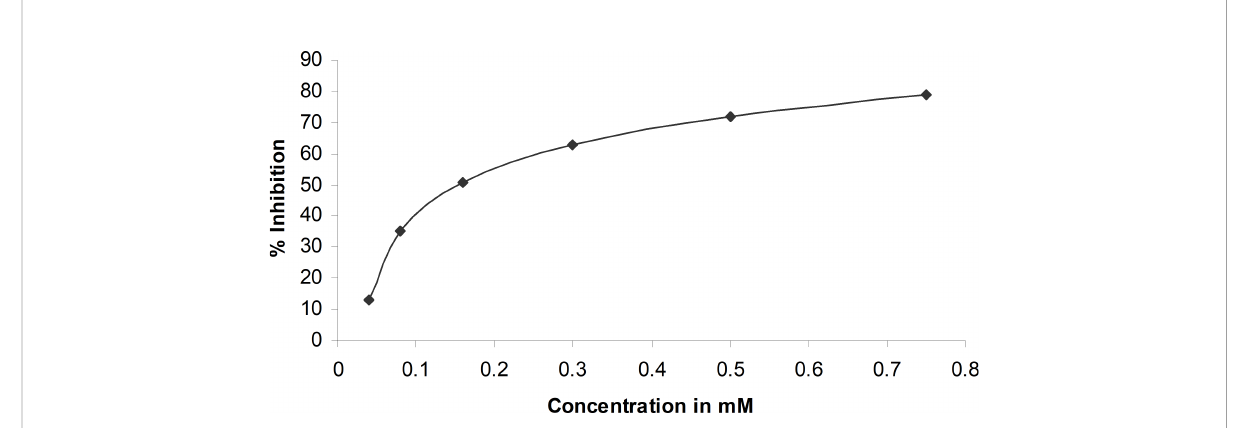
FIGURE 1 Percent inhibition of aldose reductase at different concentrations of esmolol